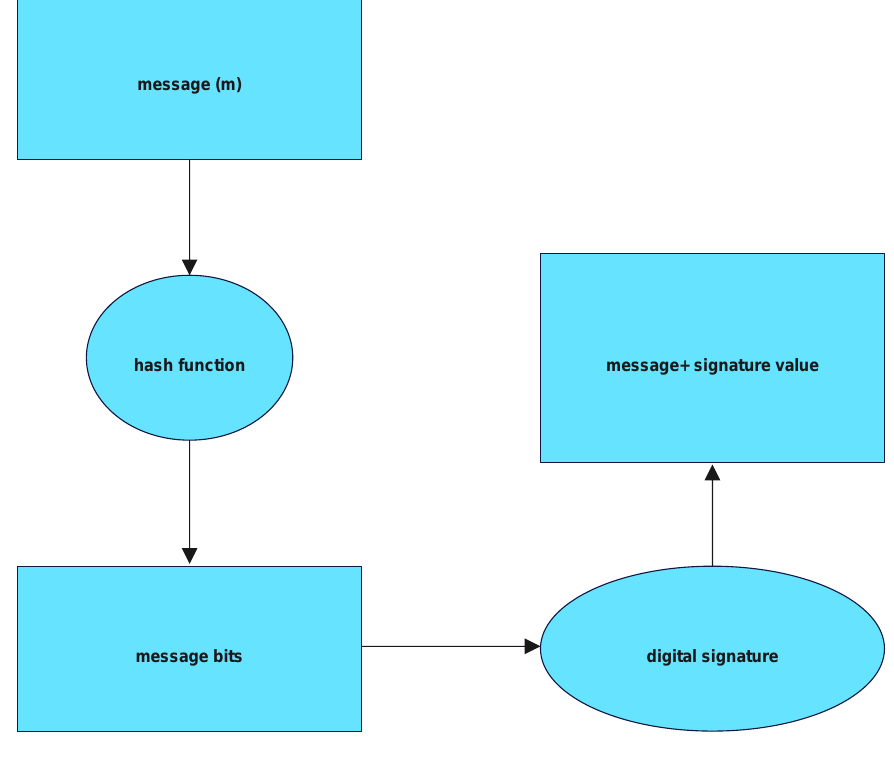
Figure 2. Signature Generation.